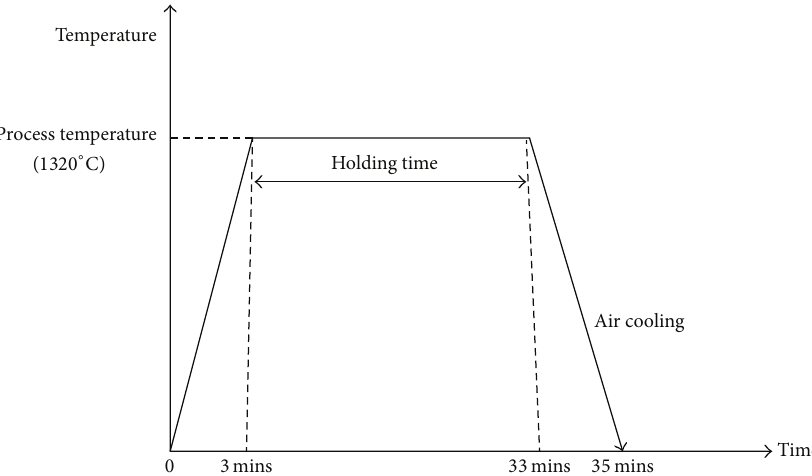
Figure 3: Temperature profile of sample inside vertical tube furnace.